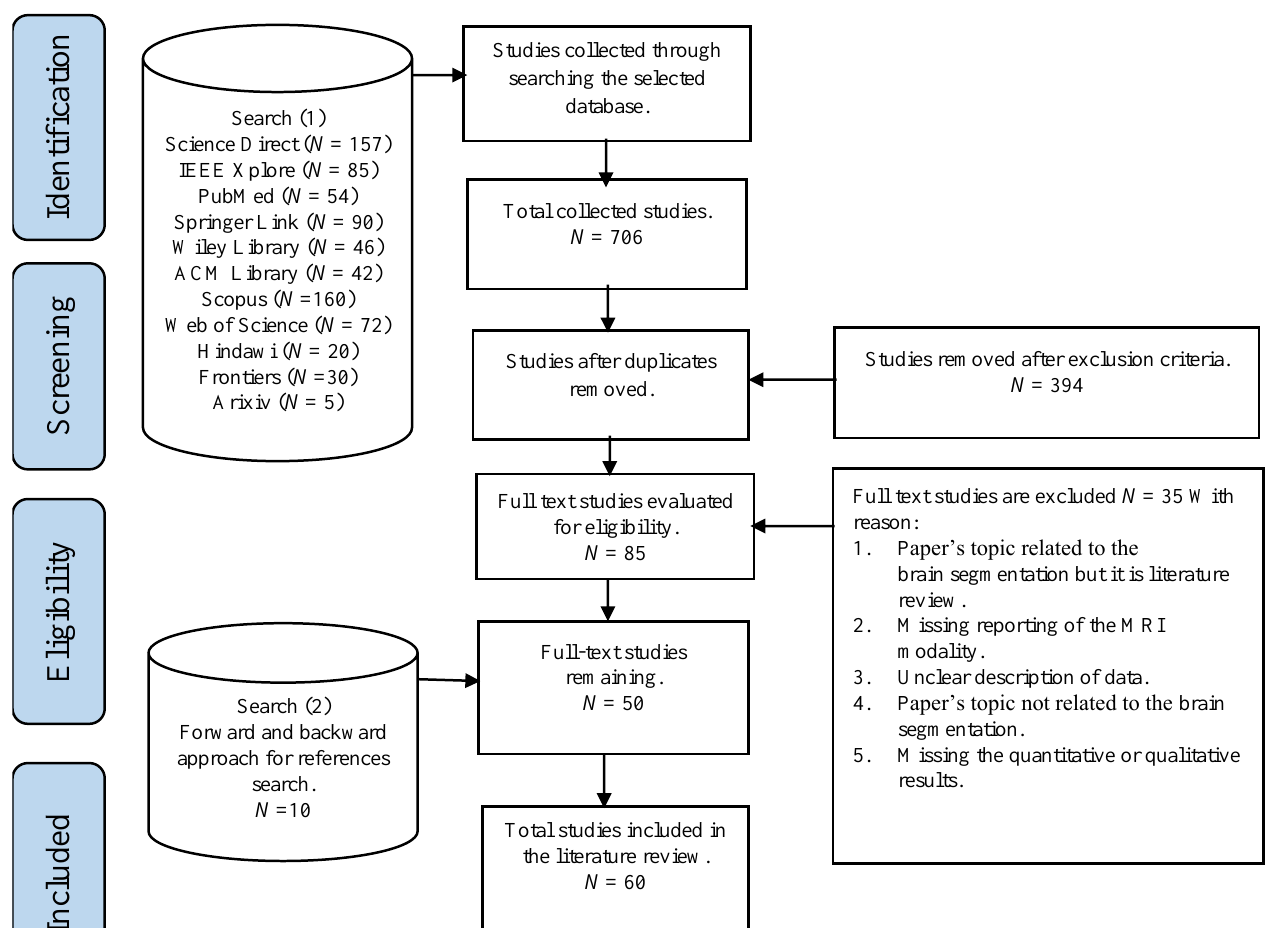
Figure 1. An overview of the study search and selection process according to PRISMA guidelines [4]. Figure 2 shows the taxonomy of reviewed research papers published in the last 5 years. It was noted that recent publications predominantly applied deep learning and hy- bridized metaheuristic-based methods for brain image segmentation.